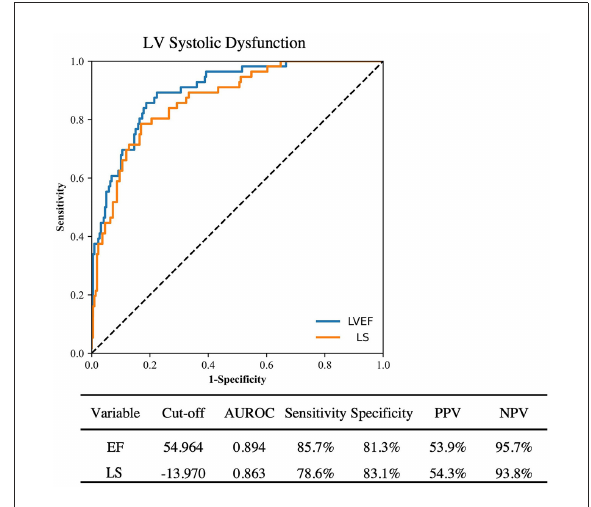
FIGURE2 ROC curve analysis for detection of clinically reported LV systolic dysfunction by automated LVEF and LS. PPV, Positive predictive value; NPV, Negative predictive